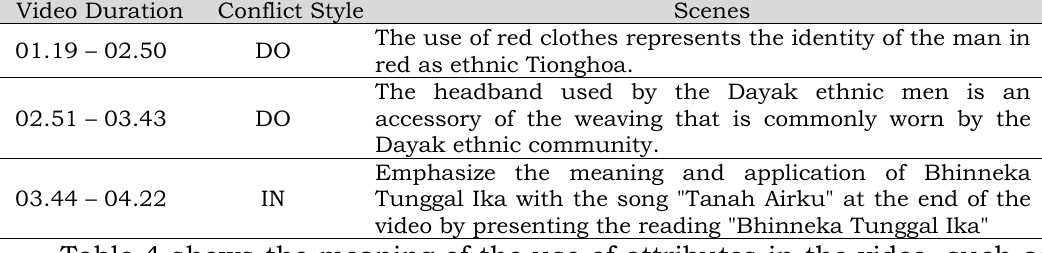
Table 4. Meaning of conflict style in video as Icons Video Duration Conflict Style Scenes The use of red clothes represents the identity of the man in 01.19 – 02.50 DO red as ethnic Tionghoa. The headband used by the Dayak ethnic men is an 02.51 – 03.43 DO accessory of the weaving that is commonly worn by the Dayak ethnic community. 03.44 –